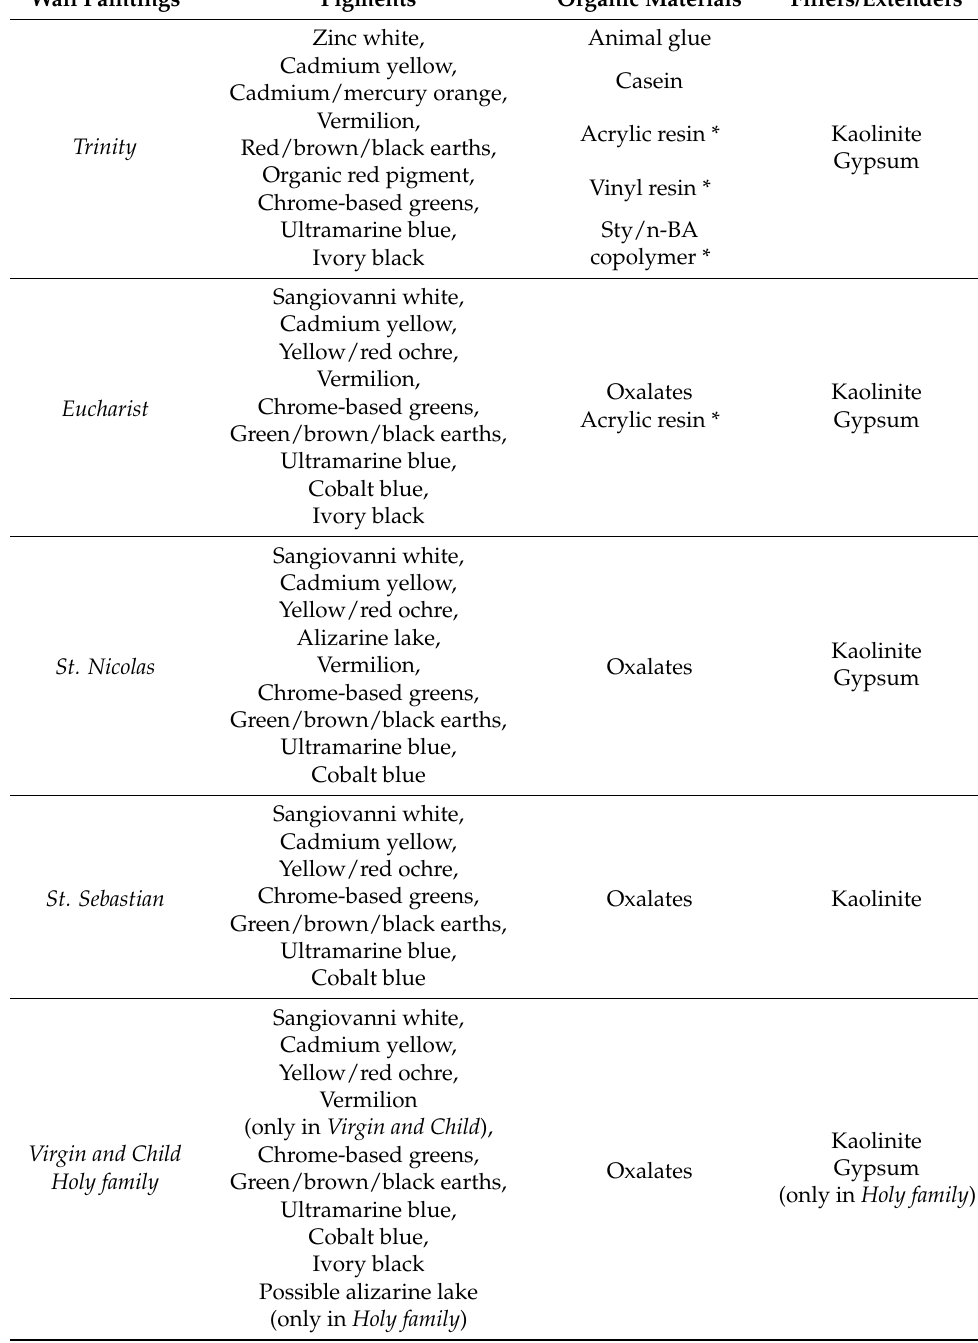
Table 2. Summary of the analytical results obtained from the study of Semsales wall paintings. Wall